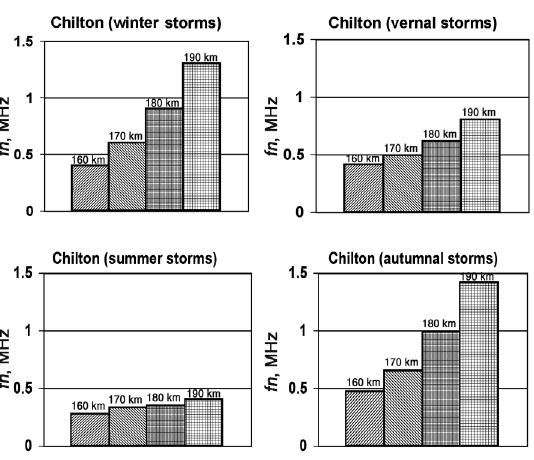
Fig. 12.1. The magnitude of the mean electron density decrease at the fixed F 1-region heights (the difference between pre-storm quiet days and the storm main phase at 11:00-13:00 UT) for all analysed 35 geomagnetic storms, which occurred during different seasons, for Chilton.